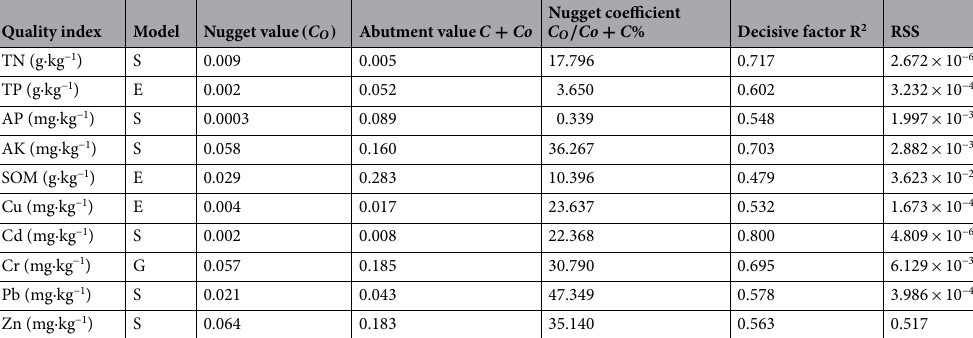
Table 3. Theoretical model and related parameters of the semi-variance function of the soil quality index. RSS residual error, TN total nitrogen, TP total phosphorus, AP available phosphorus AK available potassium, SOM